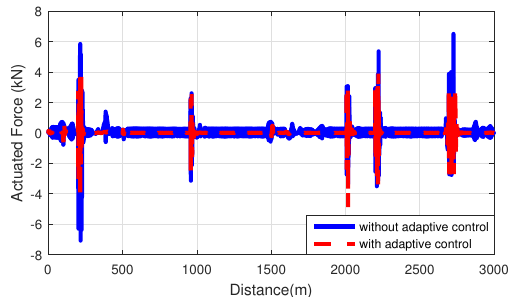
Figure 15. Actuated